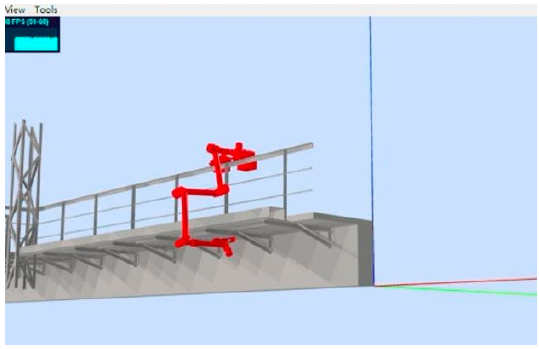
Figure 14. Snapshot of the motion simulation system for the CMBOT.